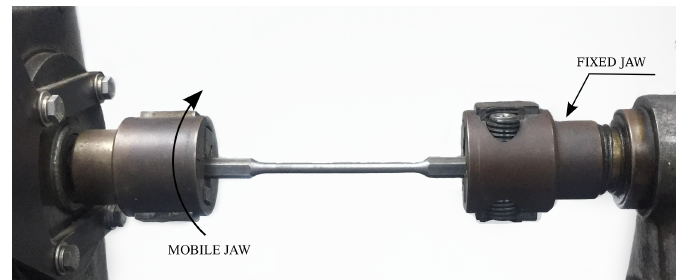
Figure 3. Setup of the torsion